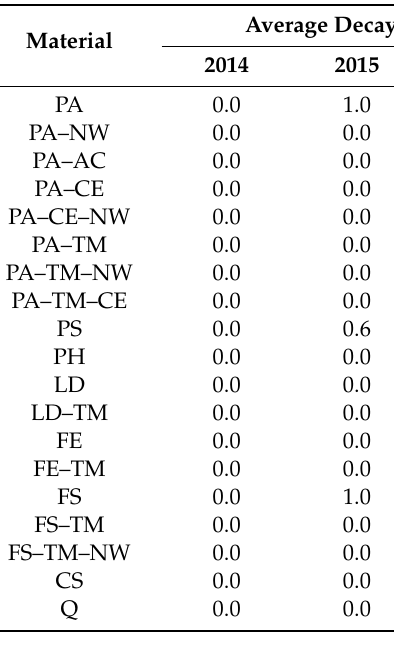
Table 5. Decay rating of the decking elements determined according to EN 252